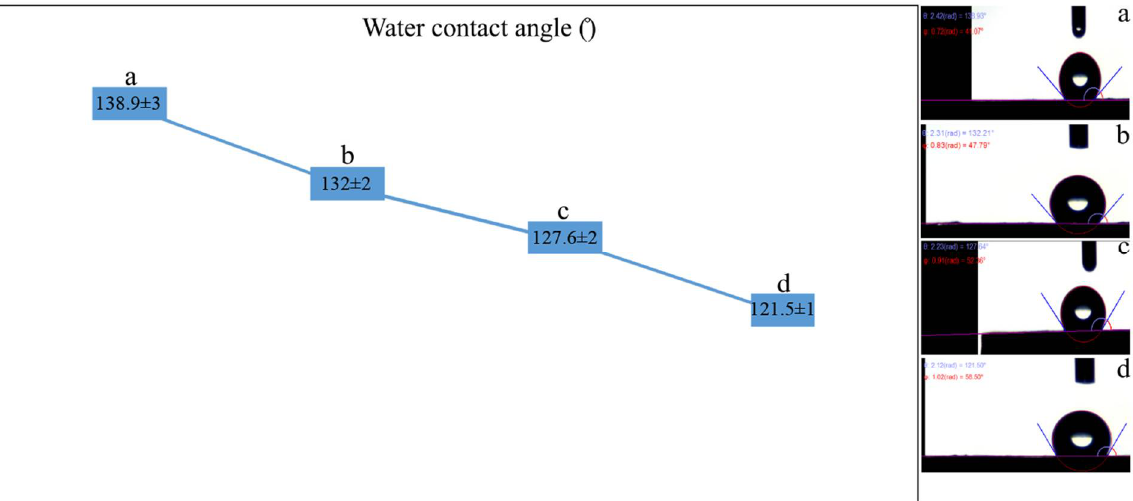
Figure 7. ATR-FTIR spectra of the fibrous scaffolds, ( a ): PCL, ( b ): 3MNP, ( c ): 5MNP, and ( d ): 10MNP.